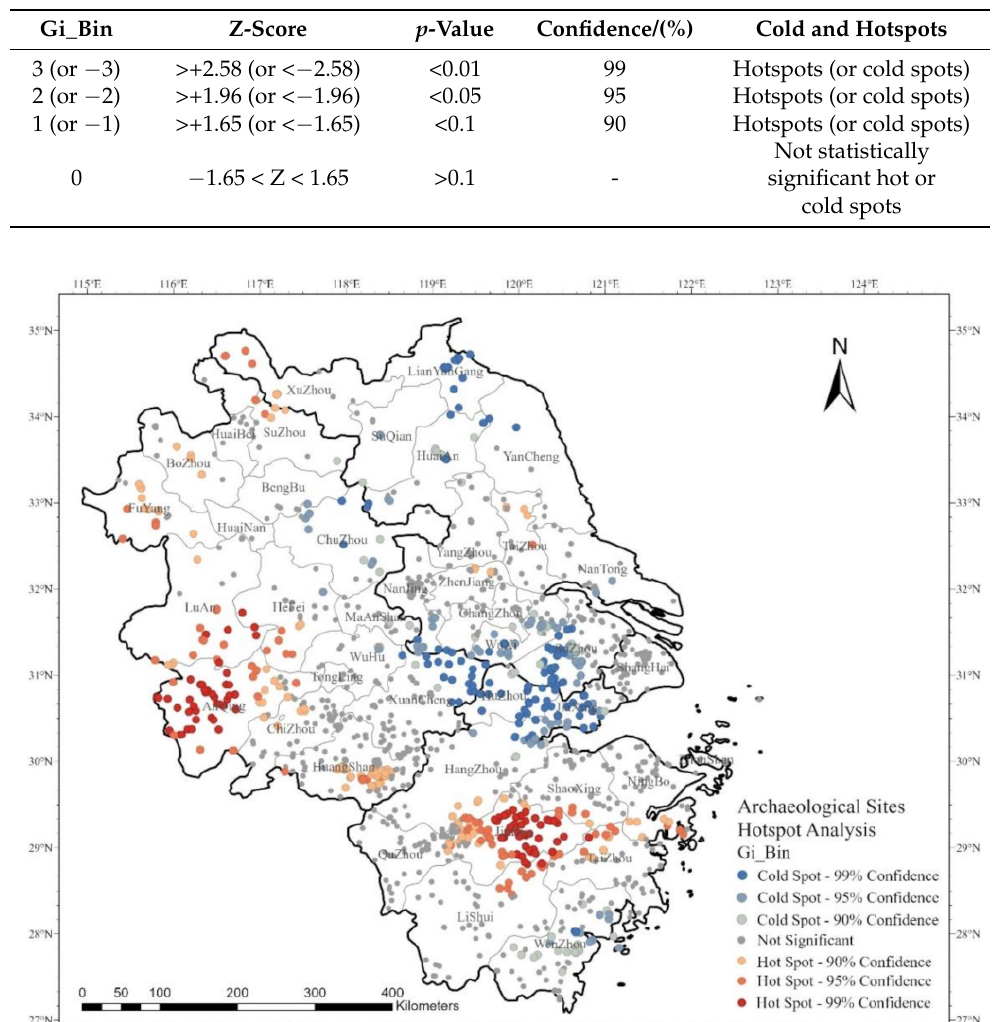
Table 2. Significant degree of cold- and hot-spots’ clustering.